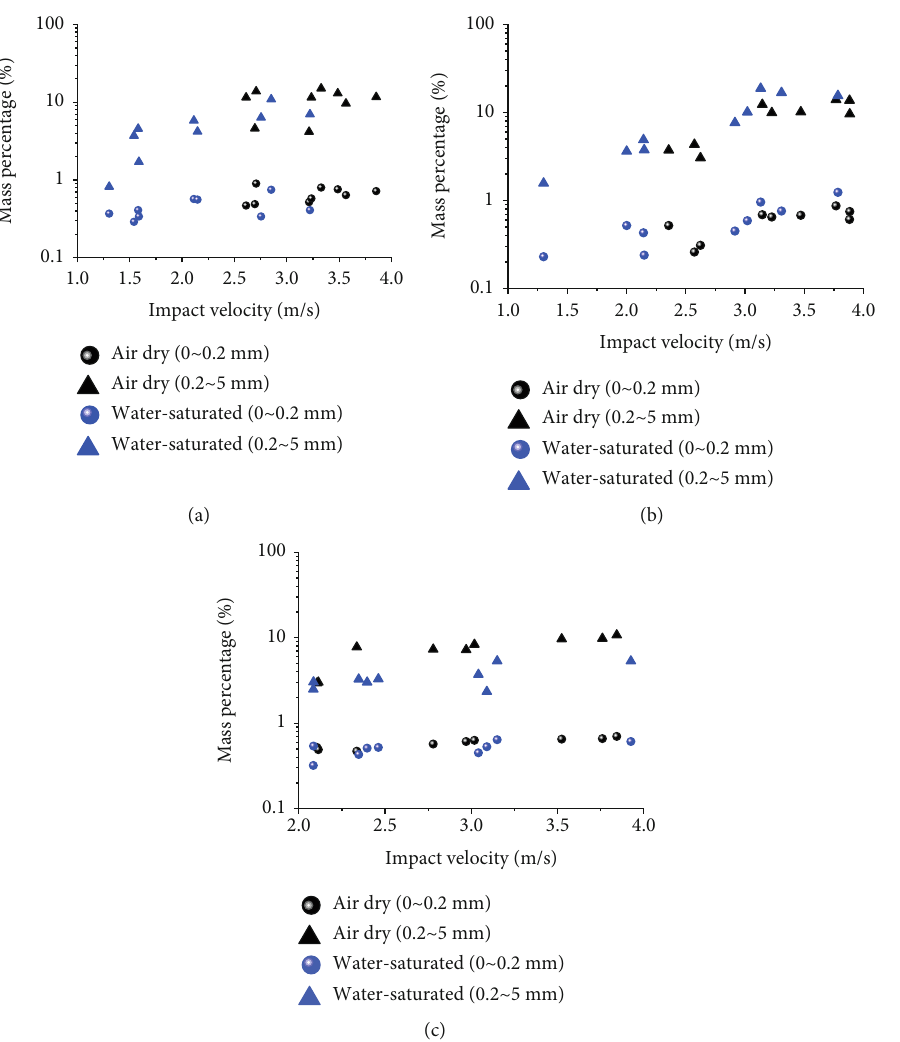
Figure 9: Size distribution of fragments of air-dry coal and water-saturated coal specimens after failure under the dynamic impact loading. From (a) to (c), the bedding angle is 0 ° , 45 ° , and 90 ° , respectively. Table 4: Statistics of the average value of debris of two particle sizes for dry and water-saturated coal samples after impact loading. ~ 0.2mm, dry, θ (0